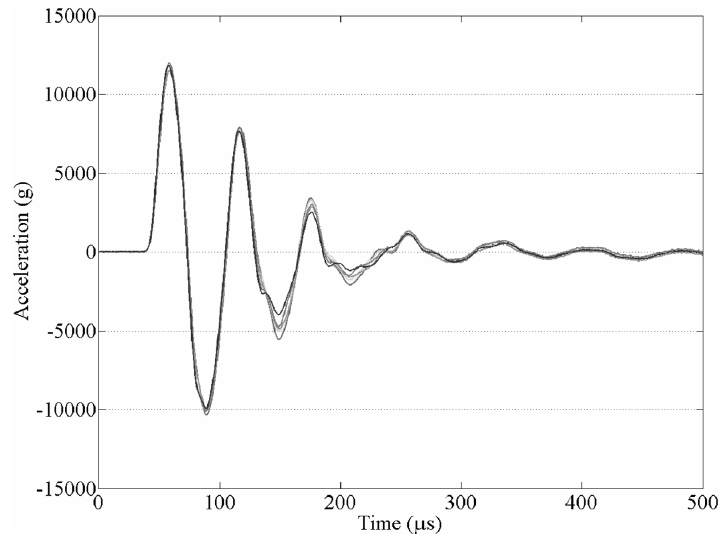
Fig. 5. VAMP acceleration plots displaying the repeatability of the pulse shape for six tests applying a consistent impact velocity of 3.5 m/s for each